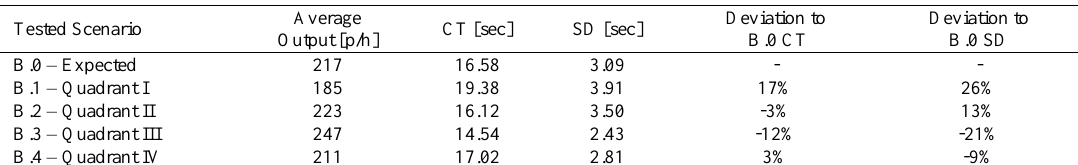
Table 5. Scenarios B results - 8 workers